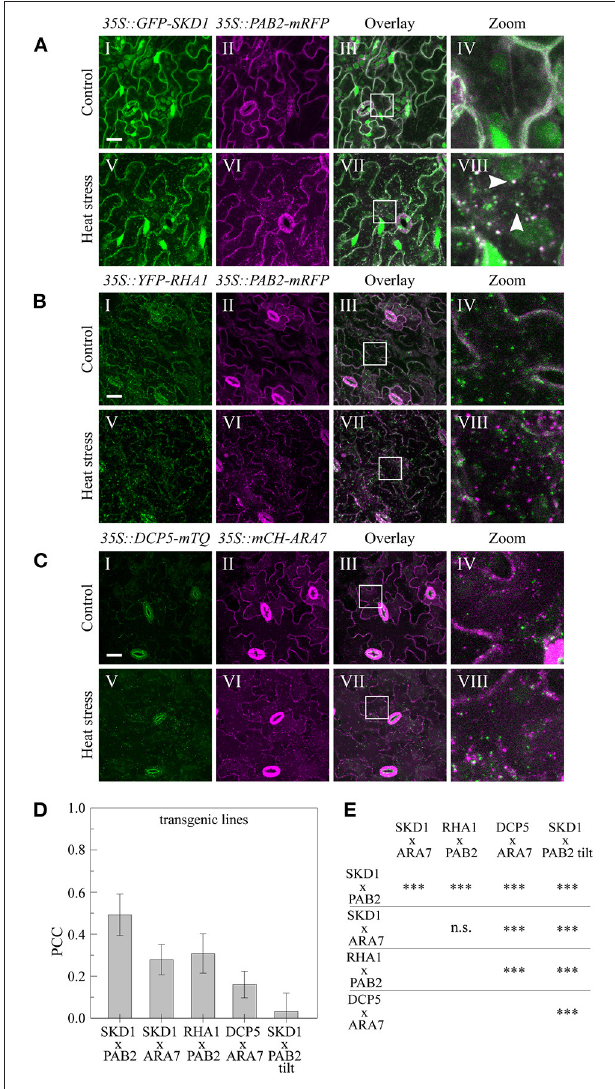
FIGURE 4 | Subcellular localization of endosomal and mRNP granule marker proteins in transgenic lines. Leaves of the generated stable lines (A) 35S::GFP-SKD1x35S::PAB2-mRFP , (B) 35S::YFP-RHA1x35S::PAB2-mRFP , and (C) 35S::DCP5-mTQx35S::mCHERRY-ARA7 were imaged by CLSM before (I–IV) and after (V–VIII) heat stress. Scale bar = 20 µ m. (D) Quantification of co-localization in the transgenic marker lines after heat stress. For each line, 10 leaf areas were imaged and PCCs of 3 ROIs per image were measured. As a negative control, one channel of the 35S::GFP-SKD1x35S::PAB2-mRFP pictures was rotated by 180 ◦ before analysis. (E) Statistical analysis of co-localization. Significance levels are indicated as following: n.s.,